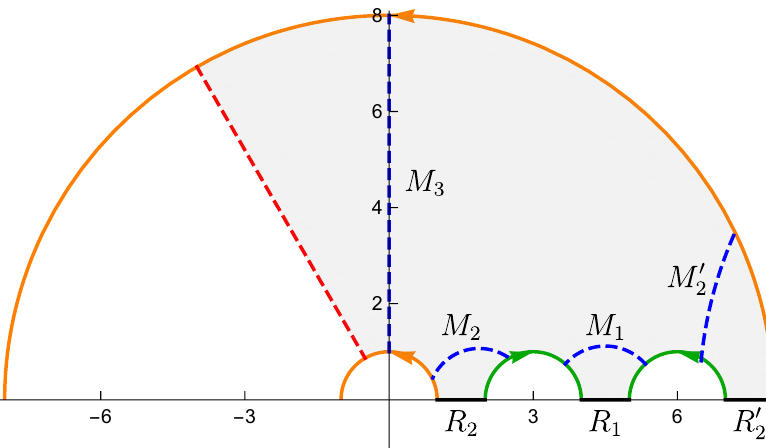
Figure 13 . Geodesic arcs M 1 , M 2 , and M 3 (dashed blue lines) in the fundamental region whose lengths ( m 1 , m 2 , and m 3 respectively) are the moduli of the inception geometry. The arcs M 2 and are joined smoothly under the identi(cid:12)cation. M 0 2